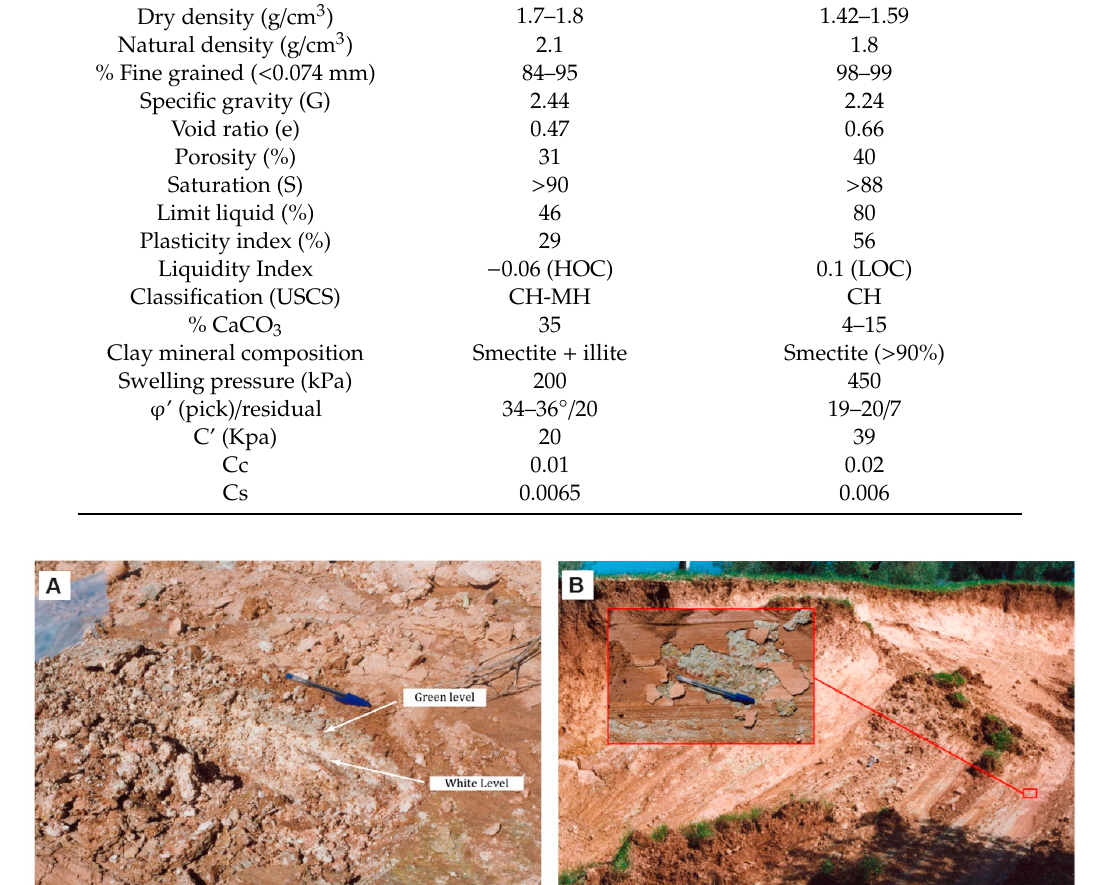
Figure 4 . ( A ) Outcrop picture located close to the secondary scarp showing the smectite-rich thin layer, which, in turn, overlays a centimeter-thick fine-grained powdery calcite layer, in the slip surface (modified from [11]). ( B ) Secondary scarp in the Diezma landslide. The box shows a detailed view with slickenside and striations on the landslide slip surface (modified from [11]).